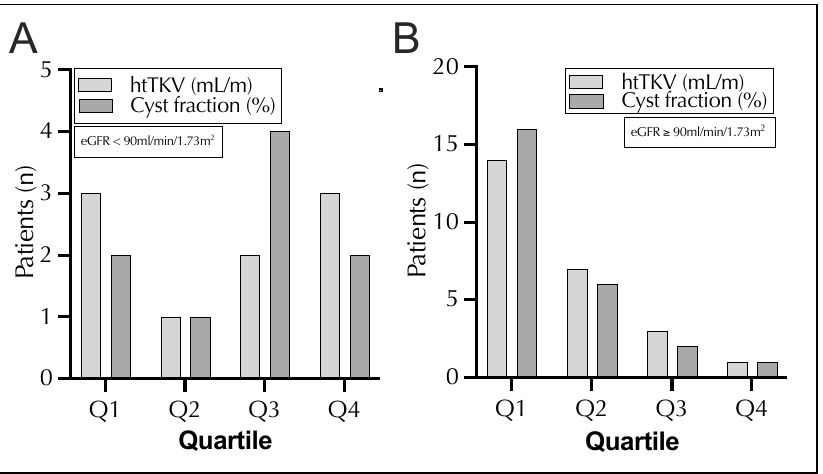
Figure 5. Quartiles of cyst fraction and htTKV of patients < 40 years of the subcohort year 1 ( n = 98) for either eGFR < 90 ( A ) or ≥ 90 ( B ) mL/min/1.73 m 2 . eGFR, estimated glomerular filtration rate; htTKV, height adjusted total kidney volume.